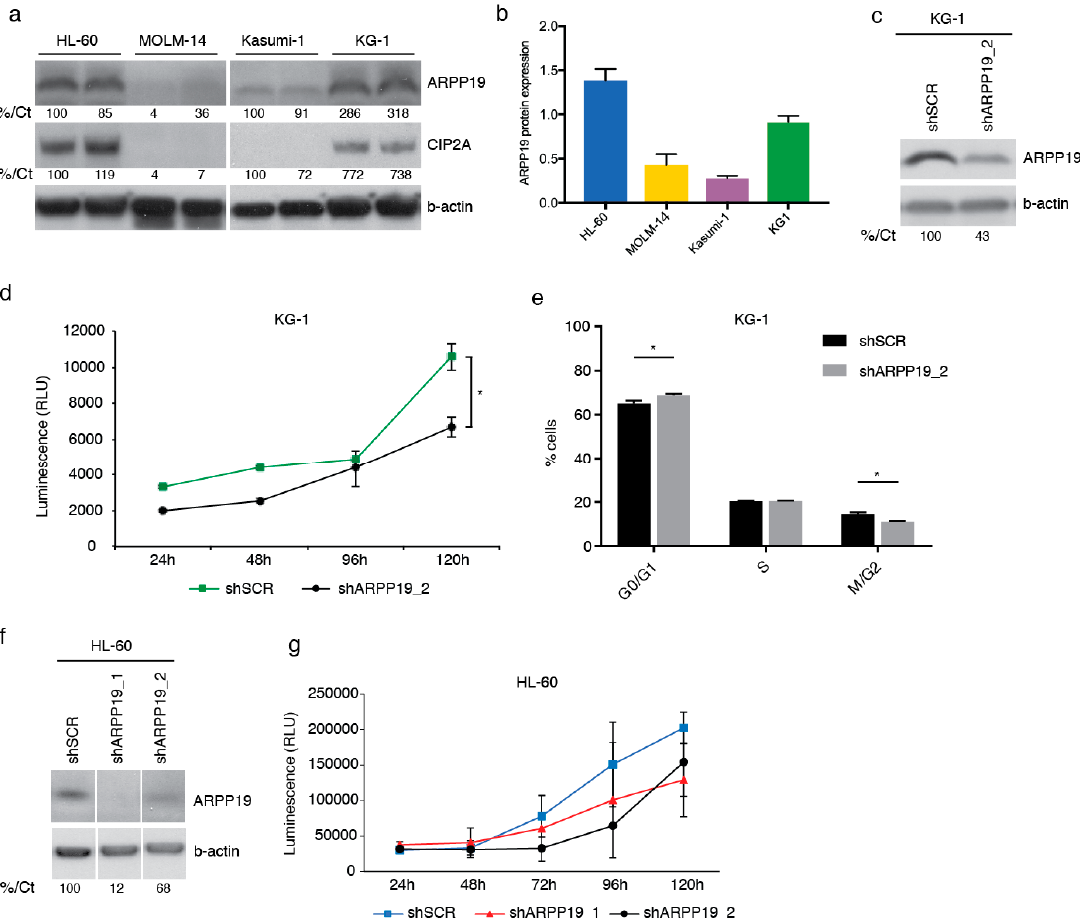
Figure 2. ARPP19 expression promotes AML cell survival. ( a ) Representative Western blot analysis of endogenous ARPP19 and CIP2A expression in HL-60, MOLM-14, Kasumi-1 and KG-1 cell lines. ( b ) Quantitation of ARPP19 protein levels from ( a ). B-actin was used as loading control and internal control was used to normalize the quantities on separate membranes. Internal control (T98G cell lysate) is set as 1. Shown is mean with SEM. ( c ) Representative Western blot analysis of ARPP19 expression in KG-1 cell line stably transduced with scrambled (shSCR) or ARPP19 (shARPP19_2) shRNA. ( d ) KG-1 cell viability measured with CellTiter-Glo ® (CTG) assay 24 h, 48 h, 96 h or 120 h after plating of stable shSCR or ARPP19 shRNA cells. Shown is mean ± SEM of three experiments. * p = 0.013 by Student’s t -test. ( e ) KG-1 cell cycle measured with propidium iodide staining and FACS analysis. Shown is mean ± SEM of two independent experiments, and significant values are indicated with asterisks (* p < 0.05, by 2way ANOVA). ( f ) Representative Western blot analysis of ARPP19 expression in HL-60 cell line stably transduced with scrambled (shSCR) or two different ARPP19 shRNAs (shARPP19_1 and shARPP19_2). ( g ) HL-60 cell viability measured with CTG assay 24 h, 48 h, 72 h, 96 h or 120 h after plating of stably with shSCR or two different ARPP19 shRNA transduced cells. Shown is mean ± SEM of three experiments. Numbers at the bottom of each western blot state in % the quantification of protein expression compared to control sample and normalized to b-actin expression (%/Ct).